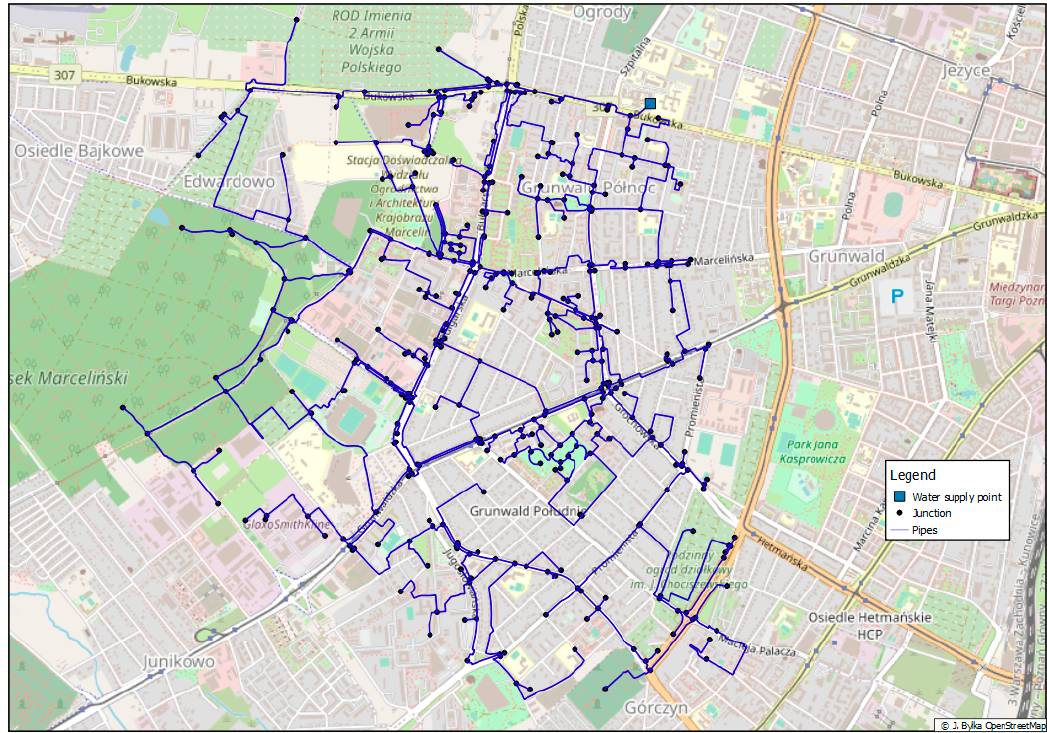
Figure 9. Analysed water supply system.